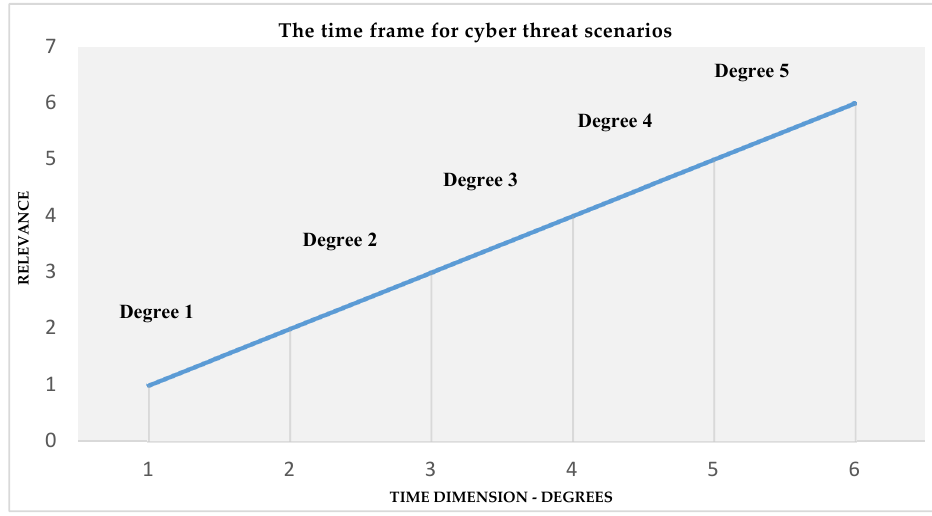
Figure 3. The time frame for cyber ‐ threat scenarios (own resource).